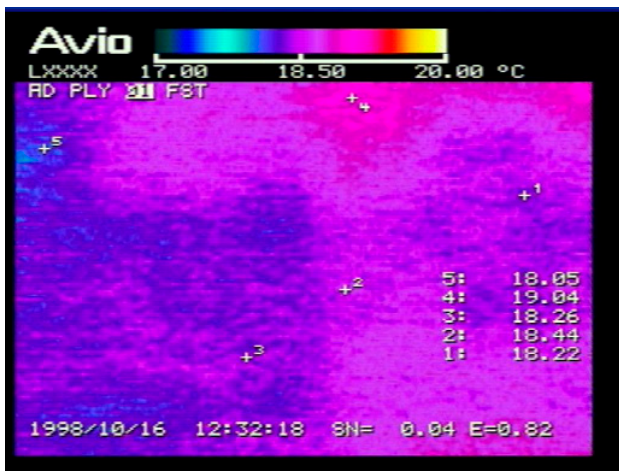
Figure 18. Thermal image of Kapandriti’s stone surface.